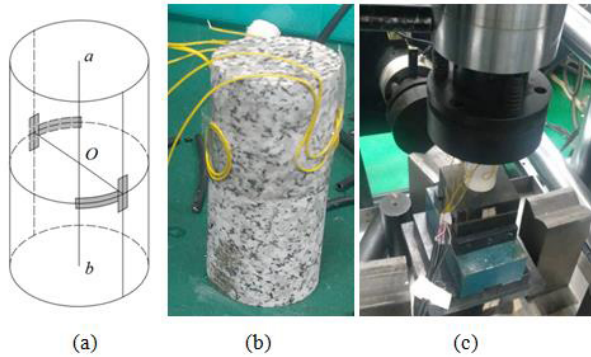
Figure 9. The layout diagram and photos of the strain gauge. system. Taking them into Eq. (8), the solution equation of each rock stress component in geodetic coordinate system is obtained.